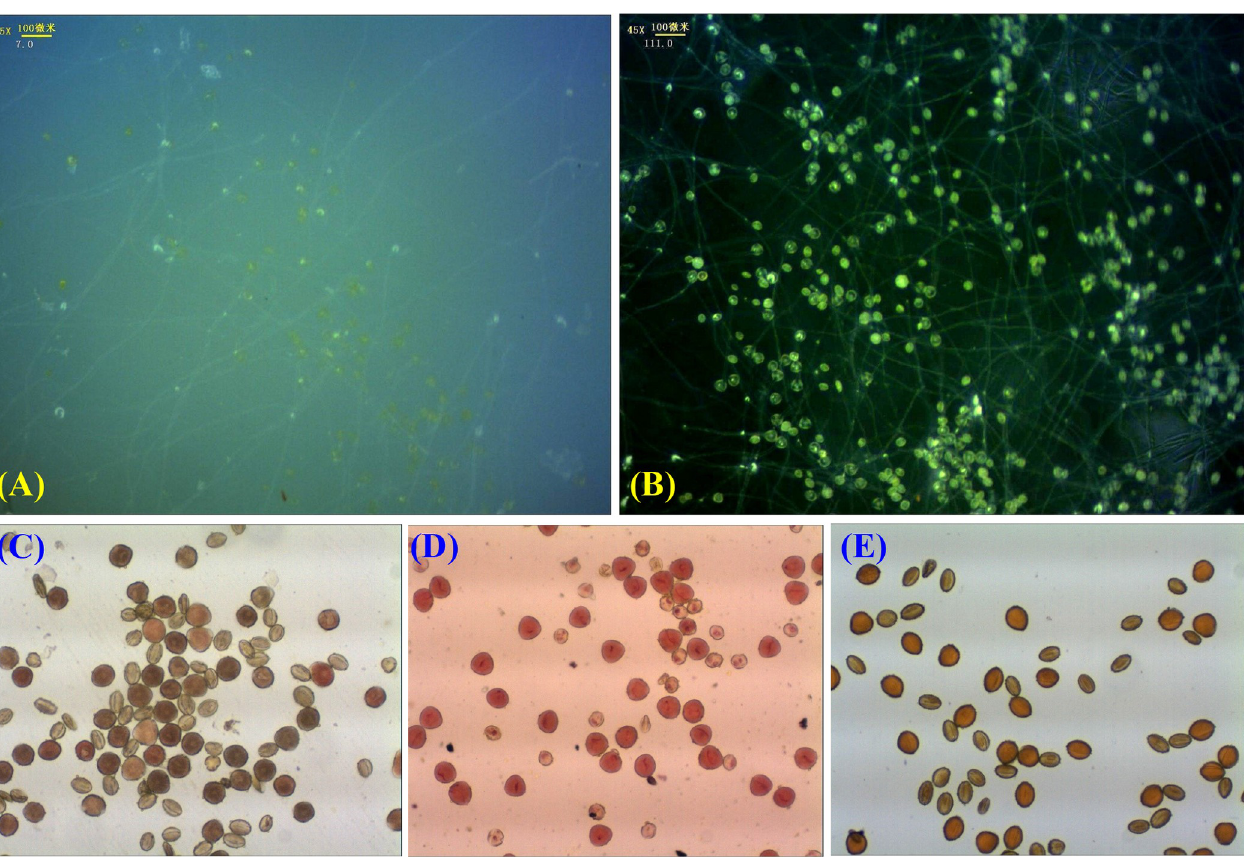
Fig 7. Observation of pollen germination based on different staining methods. (A): germination method using liquid culture medium without black background; (B): germination method using liquid culture medium with black background; (C): the TTC staining method; (D): the ACS method; (E) the IKS staining